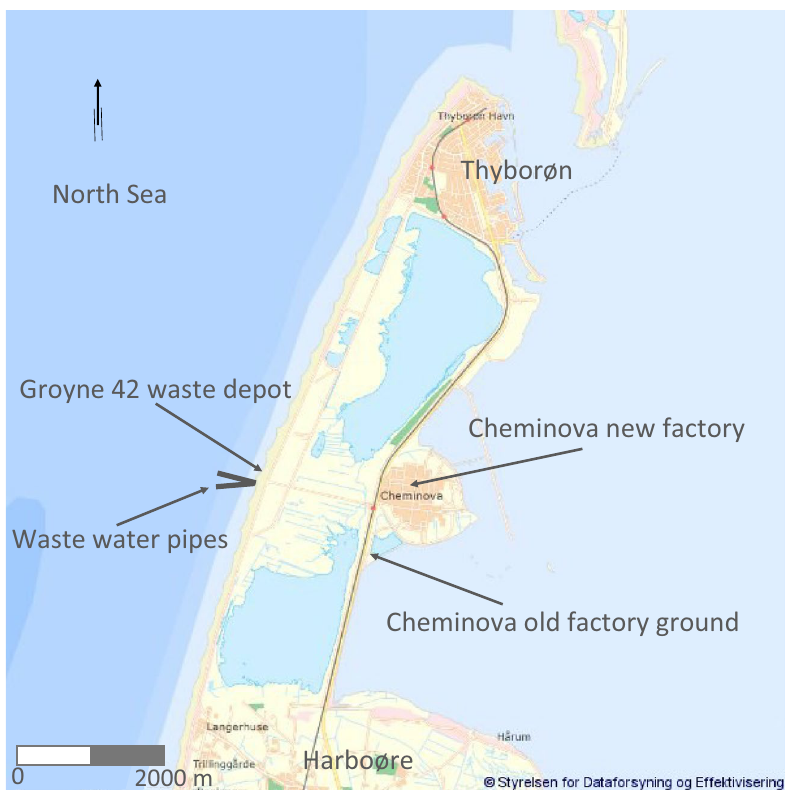
Figure 2. Detailed map of Thyborøn-Harboøre. Background map used with permission from The Danish Agency for Data Supply and Efficiency and adapted with details from 4